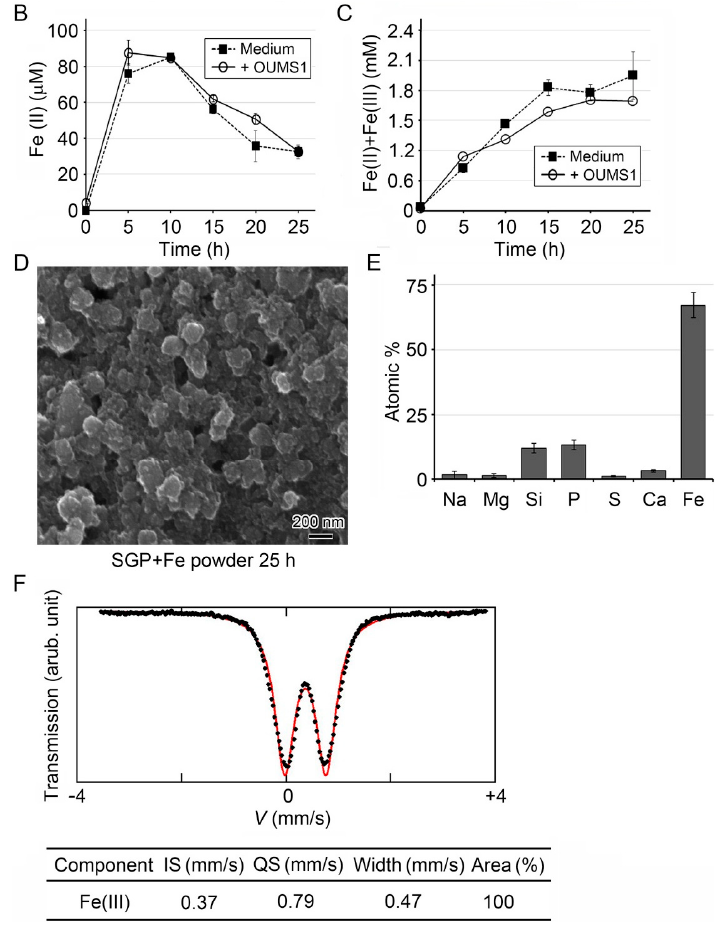
Figure 1. Fe(III) particles generated abiotically in uninoculaated SGP + Fe medium. ( A ) Visual changes in medium turbidity in uninoculated SGP + Fe; ( B , C ) Time course of change in mean (± s.d.) concentrations of Fe(II) ( B ) and Fe(II) + Fe(III) ( C ) in uninoculated (closed square) or inoculated (open circle) SGP + Fe. At least three replicates were used for each treatment; ( D ) SEM image of the particles harvested from SGP + Fe after 25 h incubation; ( E ) Atomic percentages of detectable major inorganics in the particles harvested from SGP + Fe after 25 h incubation (determined by EDX). Expressed as mean ± s.d. from n = 10 spots per sample; ( F ) Mössbauer spectrum of Fe particles generated in SGP + Fe after 25 h incubation. Note that the Fe component consisted of 100% Fe(III).